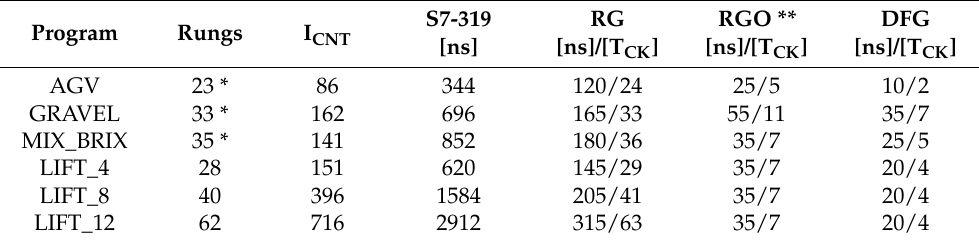
Table 3. Performance comparison with other methods and Simatic S7 PLC CPU